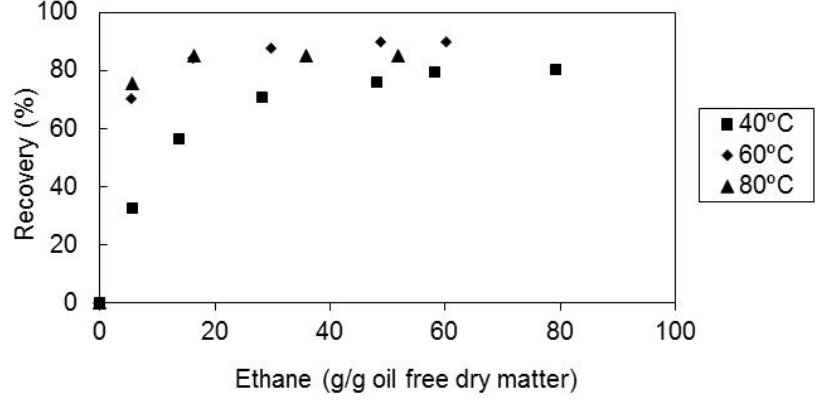
Figure 4. Recovery of all- E -lycopene from sample M2 as a function of solvent amount, at 300 bar, solvent superficial velocity of 1.44 cm/min and feed particle size of 0.36 mm, for